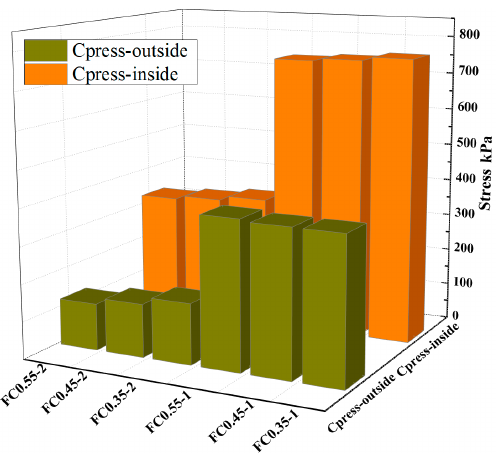
Figure 14. Contact stress of skirt under different friction coefficients.